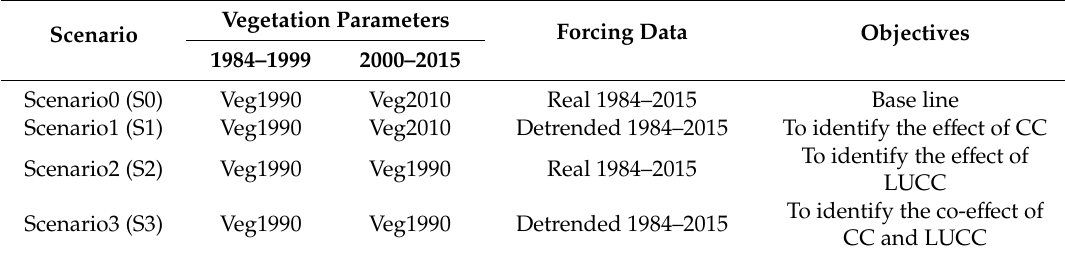
Table 1. Experiment design and simulation scenarios used to detect the impact of climate and vegetation conversions during the period